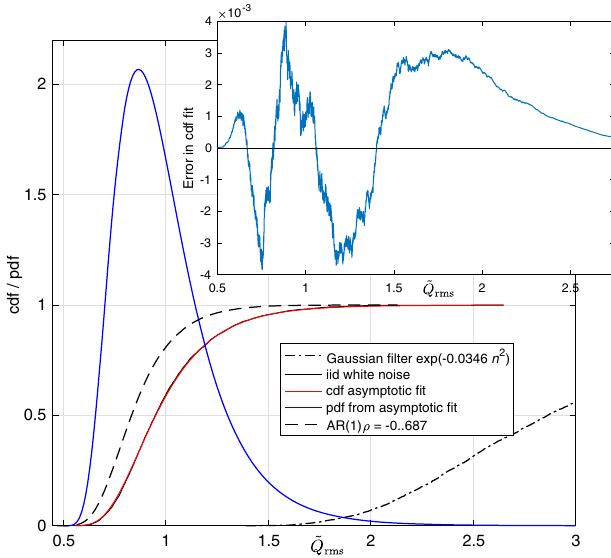
FIG. 4. Distribution of Q : A baseline cdf of Q for iid noise rms rms and the asymptotic fit given at Eq. (13) (and corresponding pdf). The fit error is shown in the inset figure. Two comparison distributions show the effect of autocorrelation. The first dis- tribution (dashed line), with a narrower scale than the standard (solid line), is generated by an AR(1) model with ρ ¼ − 0 . 68716 , which has a strong negative correlation at one time lag. The second distribution, which is broader (dash-dotted line), is generated by iid noise convolved with a Gaussian filter. The latter two coincide closely with the standard under a linear remapping of the abscissa. From Eq. (12), this result indicates that the effect of autocorrelation amounts to a change in the effective n t . Asymmetry of the distribution is clear in the pdf based on the asymptotic